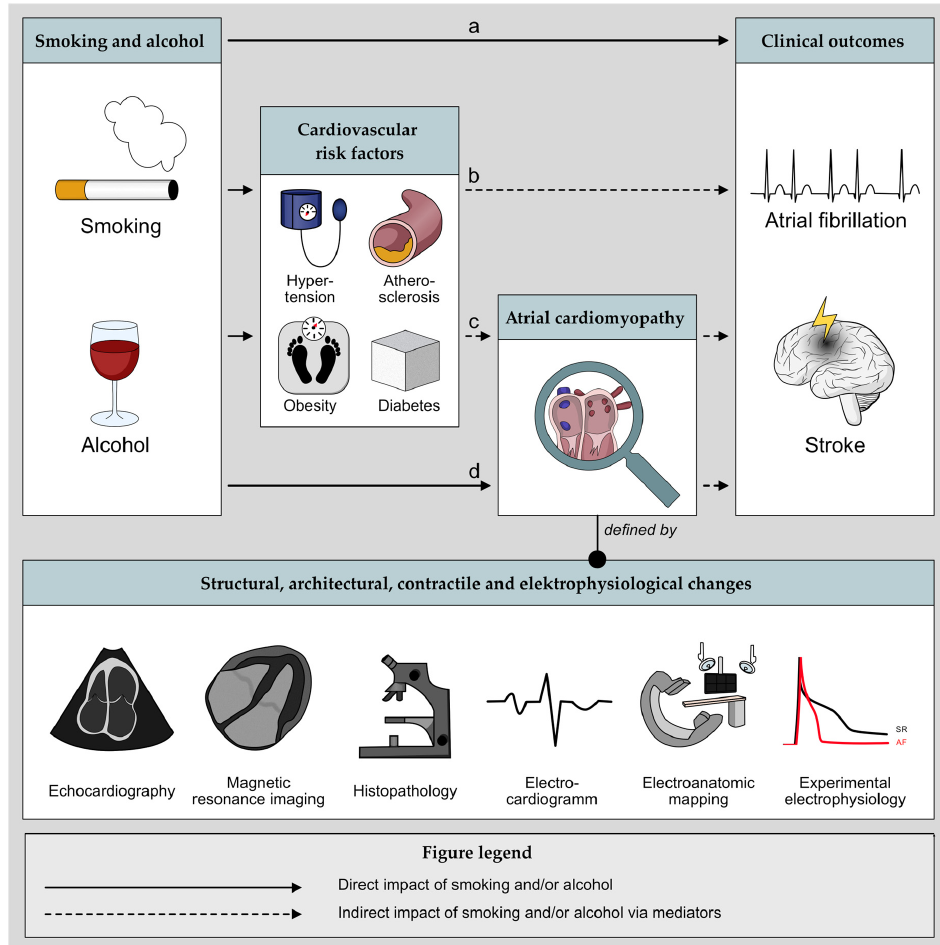
Figure 1. Schematic illustration of the potential interactions between smoking and alcohol cardio- vascular risk factors, atrial cardiomyopathy, and clinical outcomes. Hypothetically, smoking and alcohol might ( a ) directly contribute to these clinical events without the involvement of the atria or CVRF via pathways that are not yet understood; ( b ) the CVRF might contribute to the clinical outcomes without involvement of the atria; ( c ) the conditions such as hypertension might contribute to atrial cardiomyopathy as a mediator and ultimately lead to clinical outcomes; ( d ) directly affect atrial cardiomyopathy and thus facilitating clinical